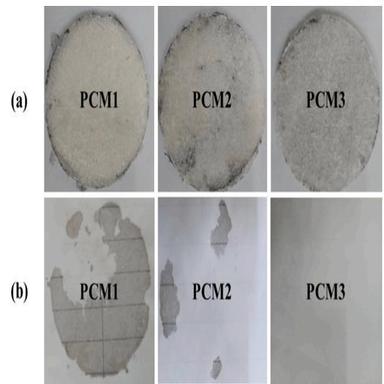
Leakage tests of D-mannitol/High-density polyethylene composites: (a) the prepared materials; (b) leakage test results.